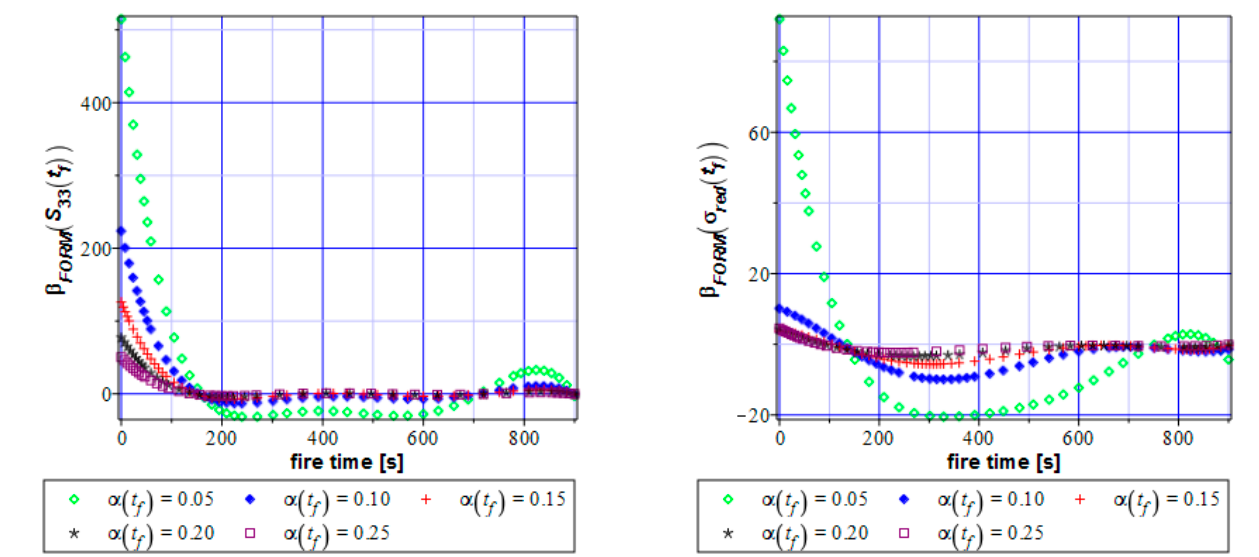
Figure 20. Reliability index for the normal stress S 33 (left graph) versus von Mises reduced stresses (right graph) according to the FORM.